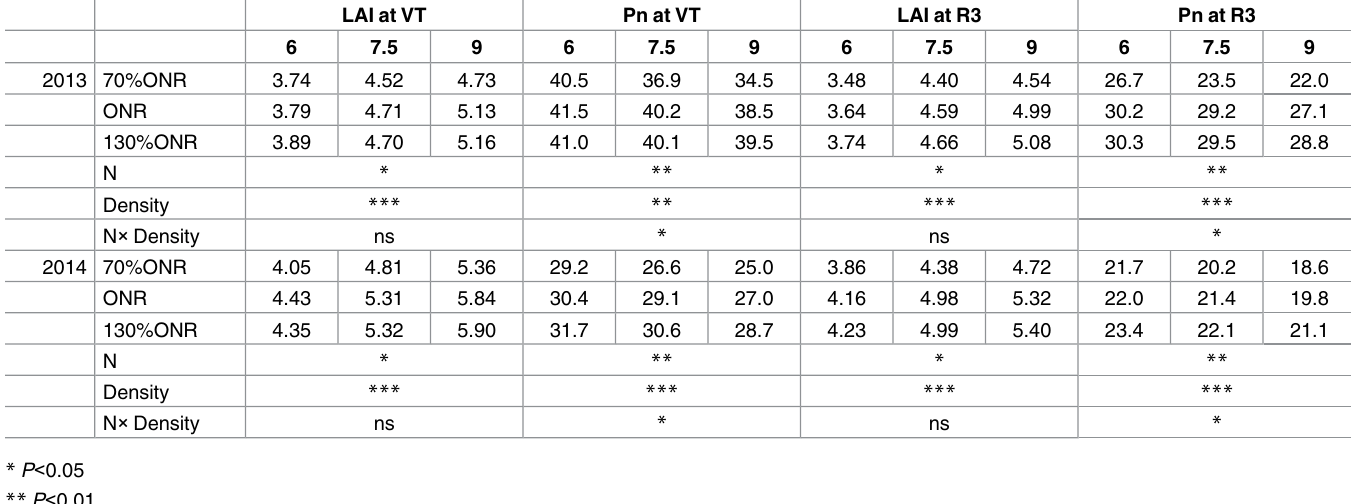
Table 3. Maize leaf area index (LAI) and spike leaf photosynthesis (Pn) as affected by three plant densities under the 70%ONR, ONR, and 130% ONR N management schemesat the silking (VT) and milking stages (R3) during the two-year study. LAI at VT Pn at